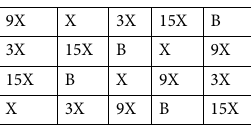
Table 1. Randomized complete block design arrangement of barley pot